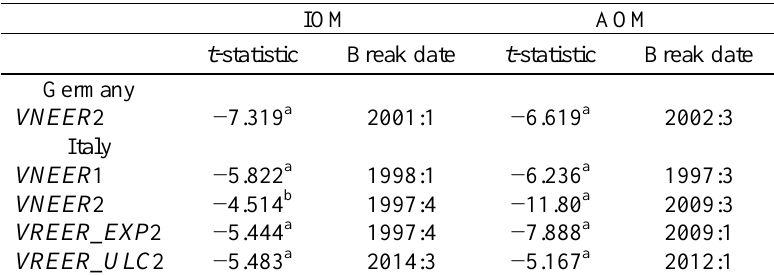
Table 4 : Unit root tests with